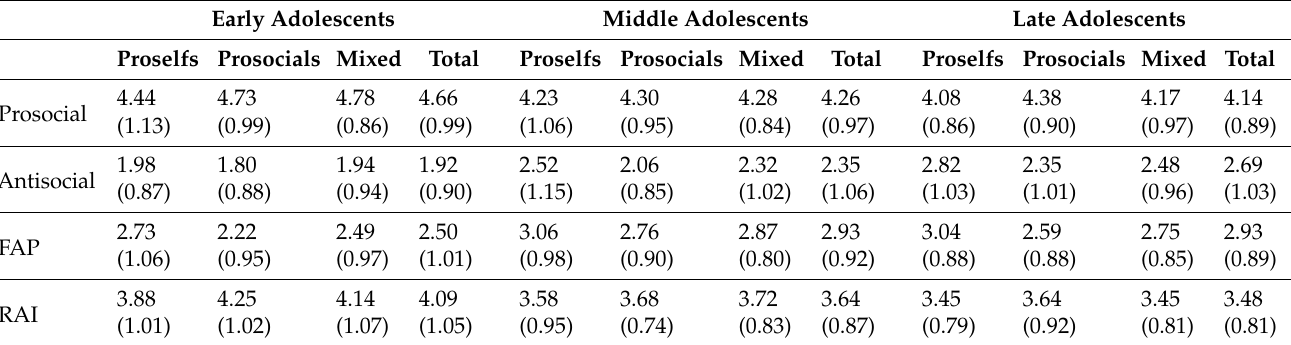
Table 4. Means and Standard Deviations for Ratings of Moral Emotion in Participants According to SVOs.